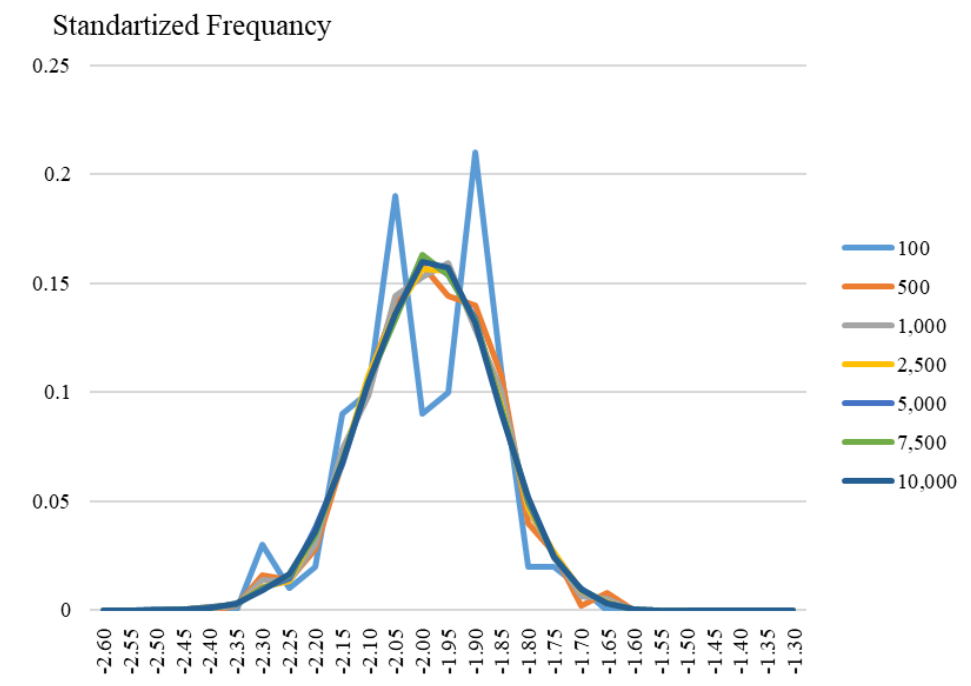
Figure 10. Comparison of the number of simulations.